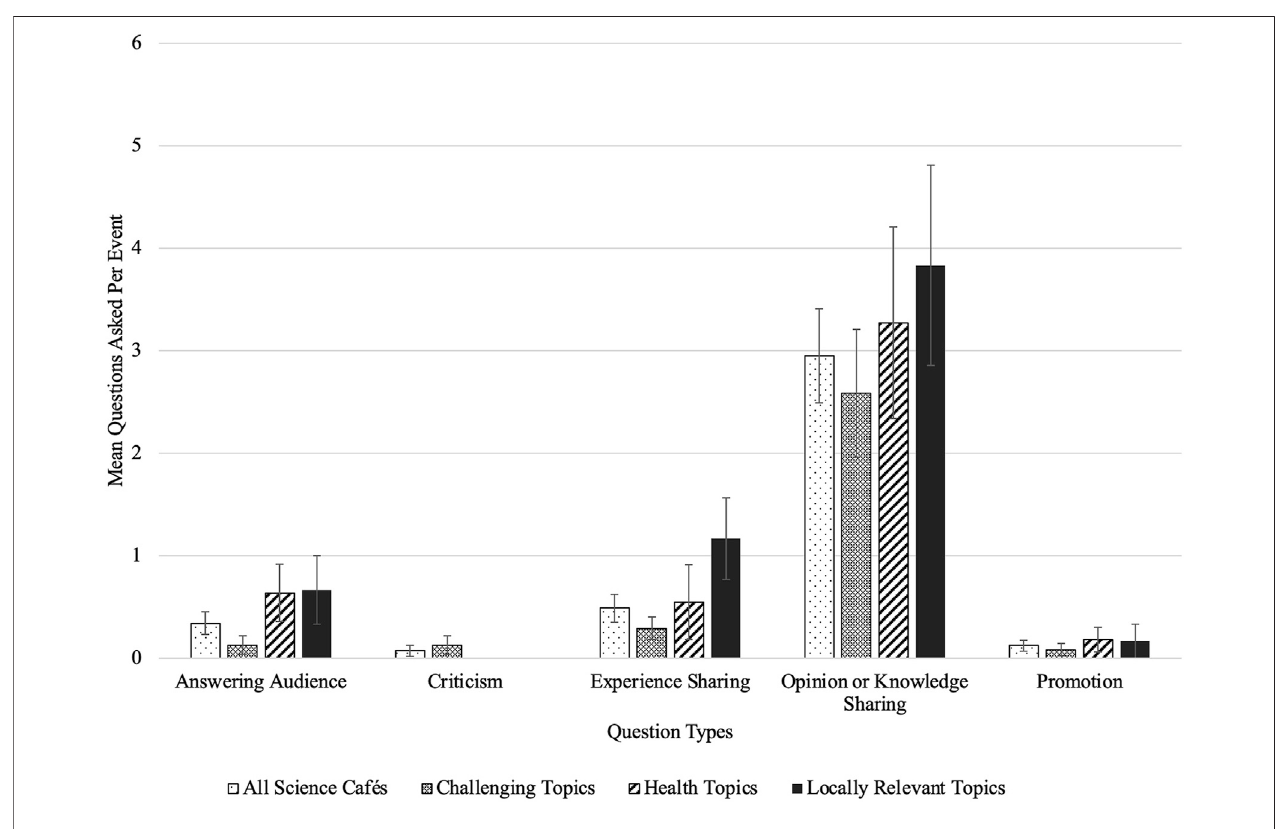
FIGURE 3 | Non-Information-seeking question types for all Science Café events.